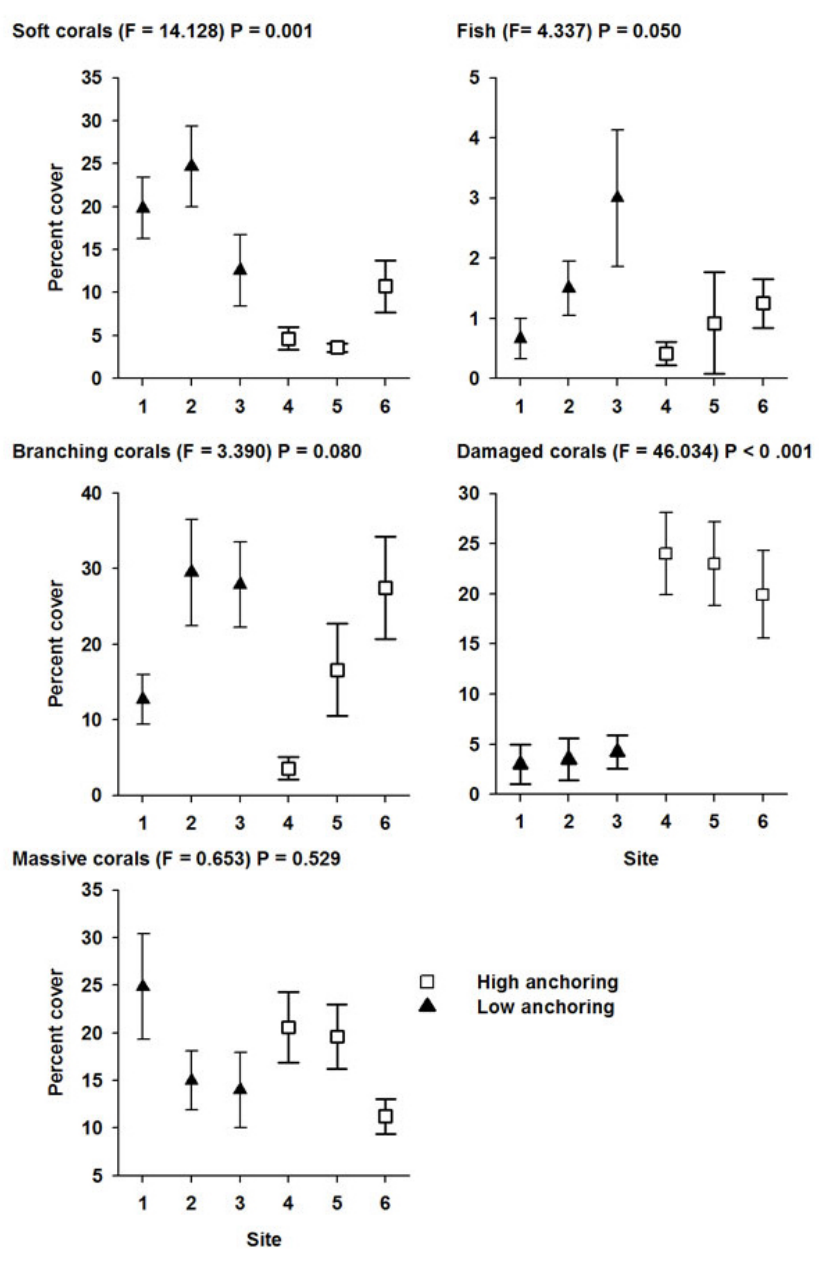
Fig. 2 . Assessment of the coral reef sites associated with high and low intensities of anchoring using the five ecological measures. The graph shows the mean cover (±SE) of each coral reef component. Results of MANOVA ( F and P values) are presented; degrees of freedom are 1:4:20. Note the difference scale on the